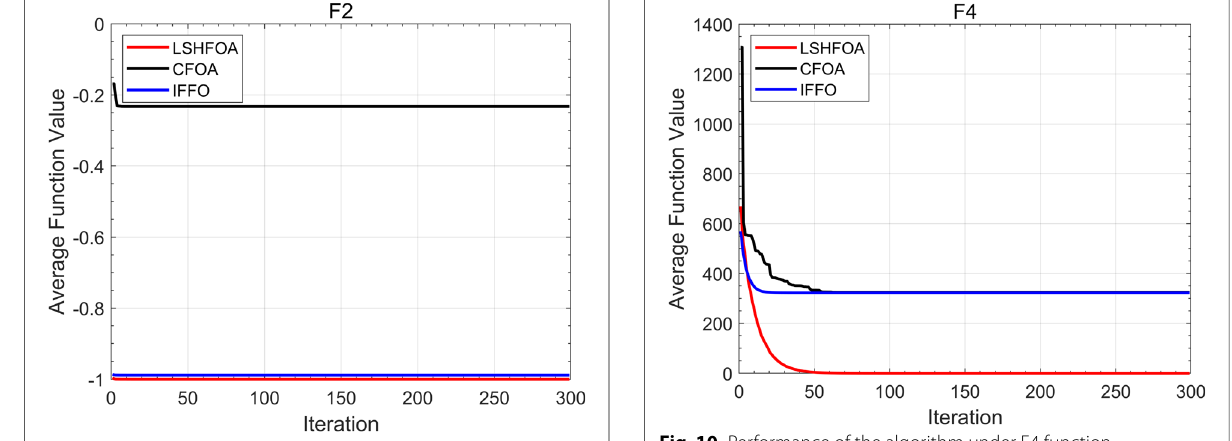
Fig. 8 Performance of the algorithm under F2 function